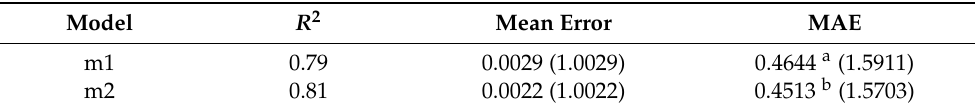
Table 3. Performance of m1 and m2 log-transformed models. The error was evaluated by a leave-one- out approach, in which a model calibrated on 18 plots is validated on the trees of the remaining plot. Mean absolute error (MAE) was significantly higher for m1 (letter a) than for m2 (letter b) according to a sign test. Errors are expressed in logarithmic units. In brackets: the back-transformed error (also called log-average